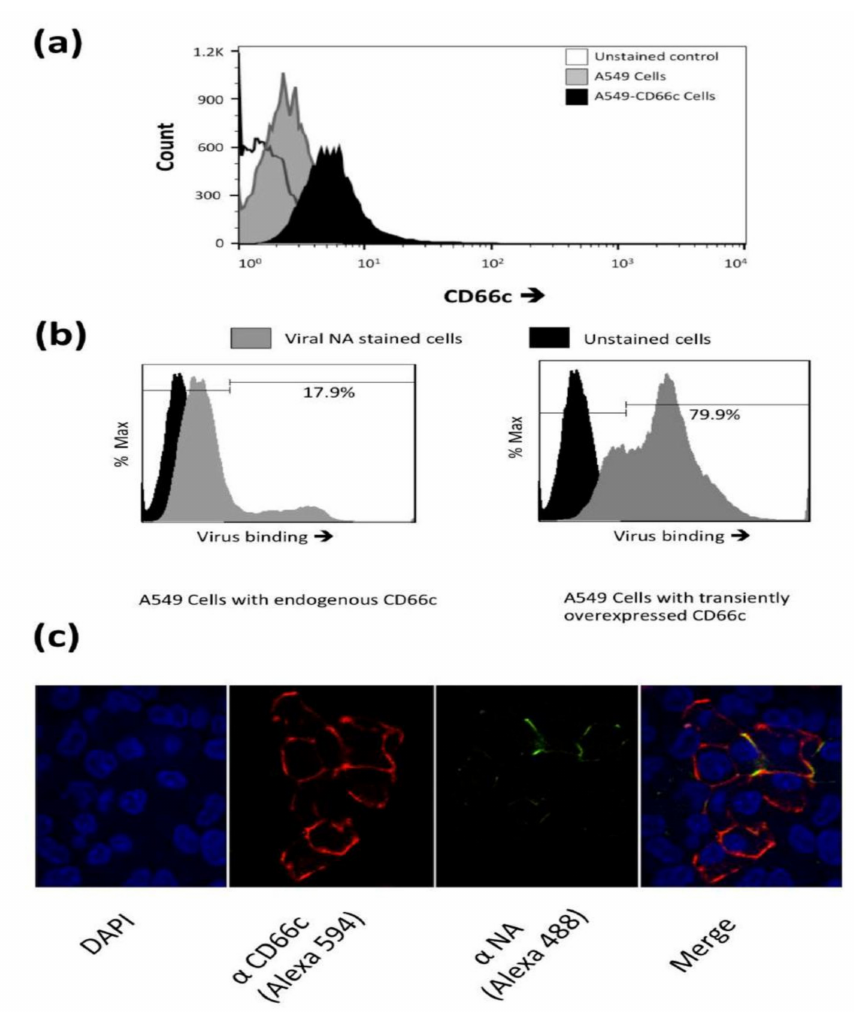
Figure 1. ( a ): Flow cytometry analysis of surface expression of CD66c in A549 cells. Cell population transiently overexpressing CD66c shows signal for higher expression of CD66c on the cell surface (black) as compared to A549 cells (grey), unstained control cells (white). ( b ): Flow cytometry analysis of virus binding on A549 cells or CD66c overexpressing A549 cells. 5 multiplicity of infection (MOI) of PR8 virus binding signal corresponding to stained NA protein (Alexa-488) of the virus on host cell surface. Signal of unstained cells (black), viral NA (grey) corresponding to the virus binding on cell surface. PR8 virus binding is increased from ~18% (left panel) to >80% of CD66c overexpressing A549 cell population (right panel). ( c ): To a monolayer of A549 cells, binding of 5 multiplicity of infection (moi) of PR8 virus was observed under confocal microscope. Panels from left to right shows cell nuclei stained with DAPI (blue), CD66c (red), Viral NA (green) at the cell periphery. Colocalization (yellow) of NA protein of PR8 virus (green) with host membrane protein CD66c (red) at the periphery of